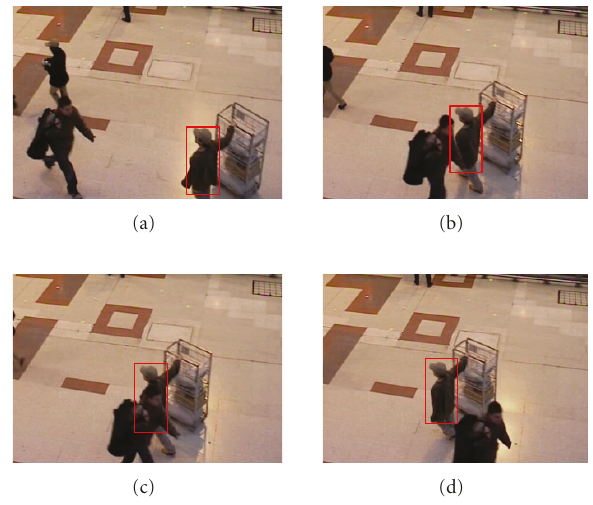
Figure 15: (a) Reference frame (Frame #1072), (b) Frame #1088,